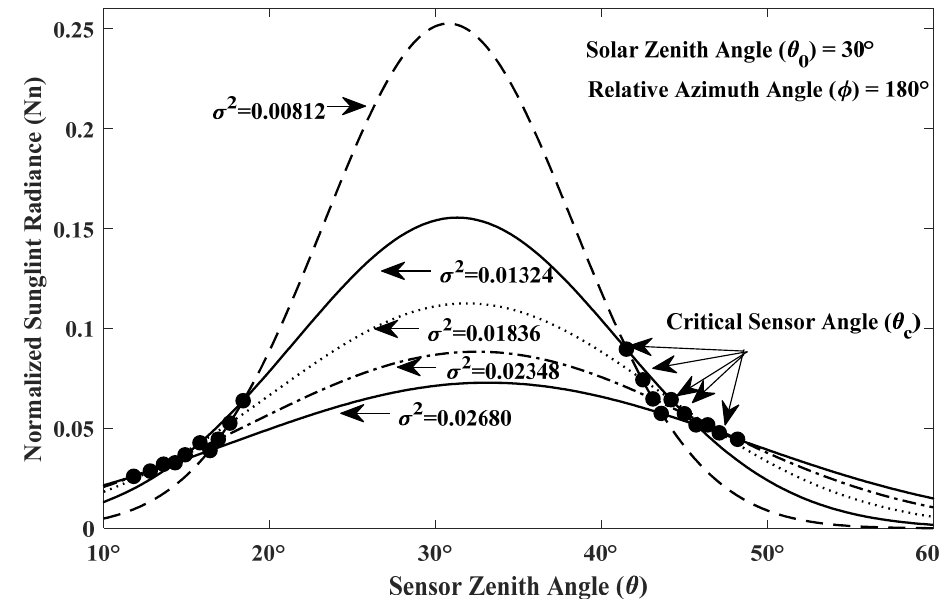
Figure 3. Schematic diagram showing the critical sensor viewing angle ( θ c ). The solar zenith angle ( θ 0 ) is 30 ◦ , and the relative azimuth angle ( φ ) is 180 ◦ , which remain fixed. The sea surface roughness variance ( σ 2 ) corresponding to the curves is 0.00812, 0.01324, 0.001836, 0.02348 and 0.02680.